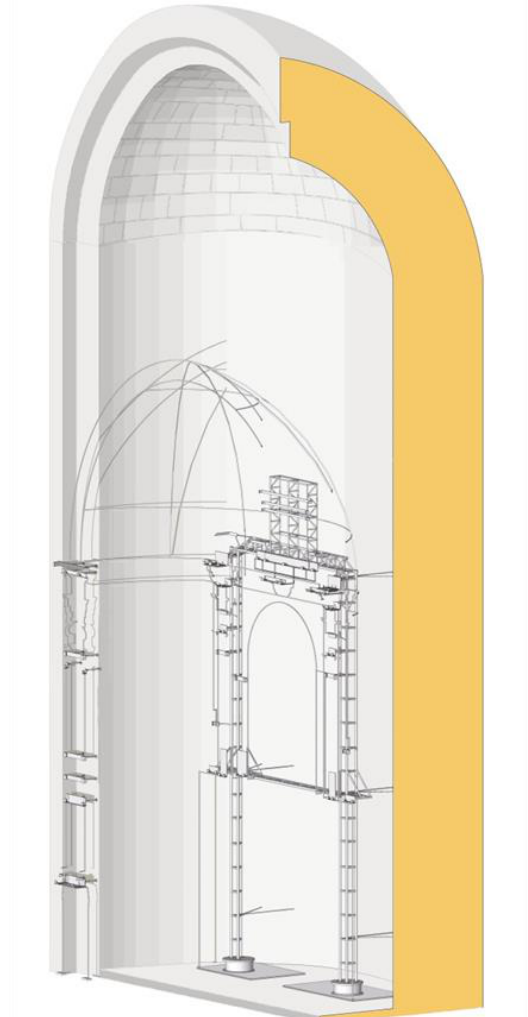
Figure 10. View of the mounting structure positioned in the apse.